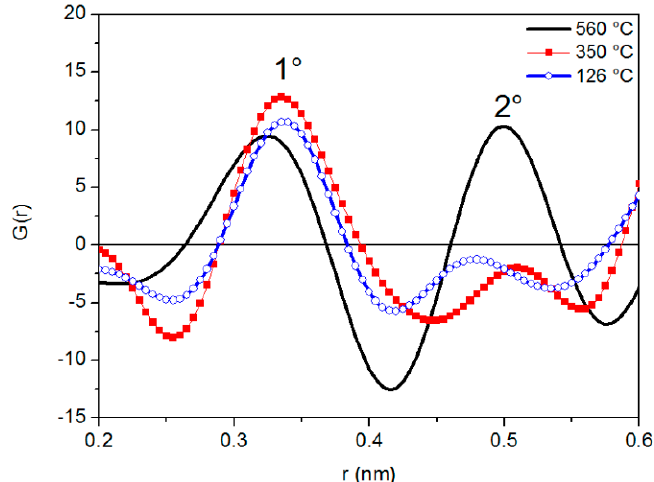
Figure 2. G(r) curves of liquid LBE at different temperatures. Figure 2. G ( r ) curves of liquid LBE at di ff erent